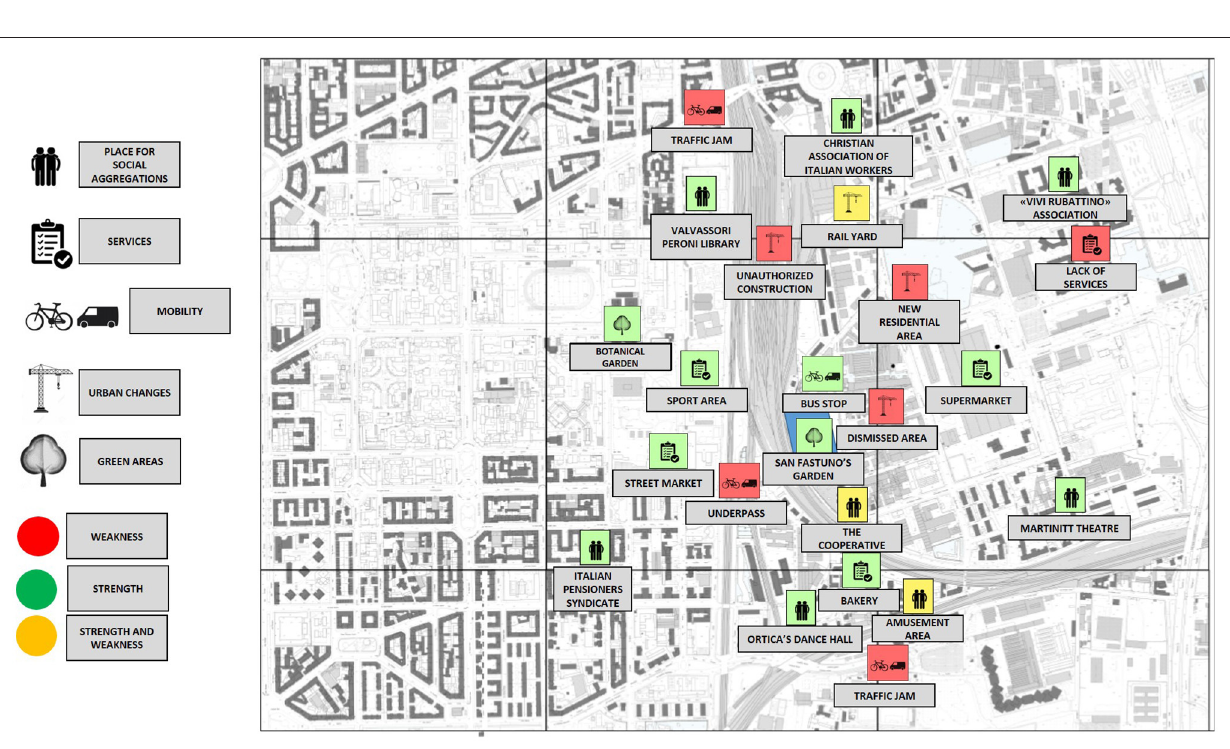
Frontiers in Psychology |